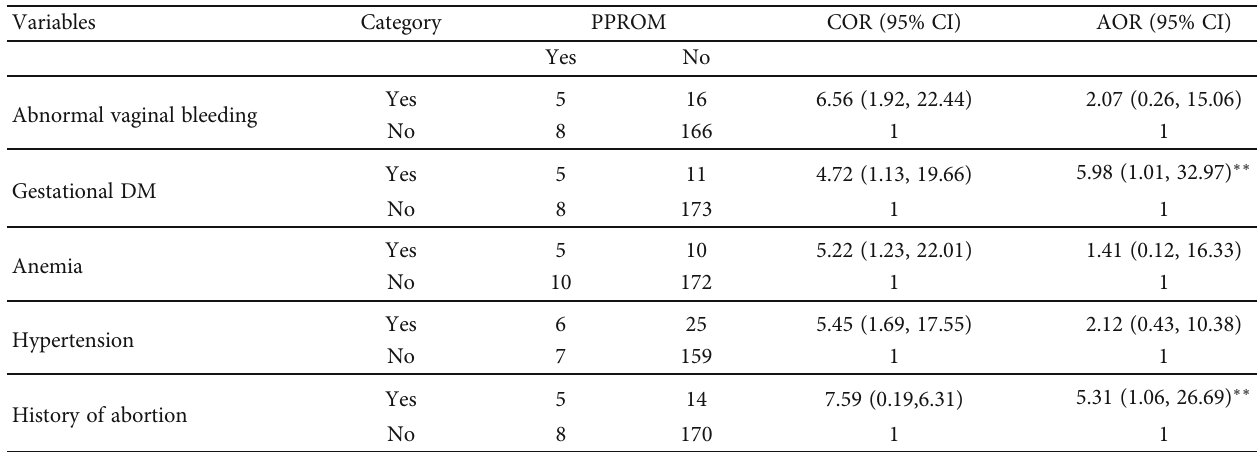
Table 3: Bivariate and multivariant analysis of factors associated with preterm premature rupture of membrane among pregnant women at Wolkite comprehensive specialized hospital, Gurage zone, southern Ethiopia,